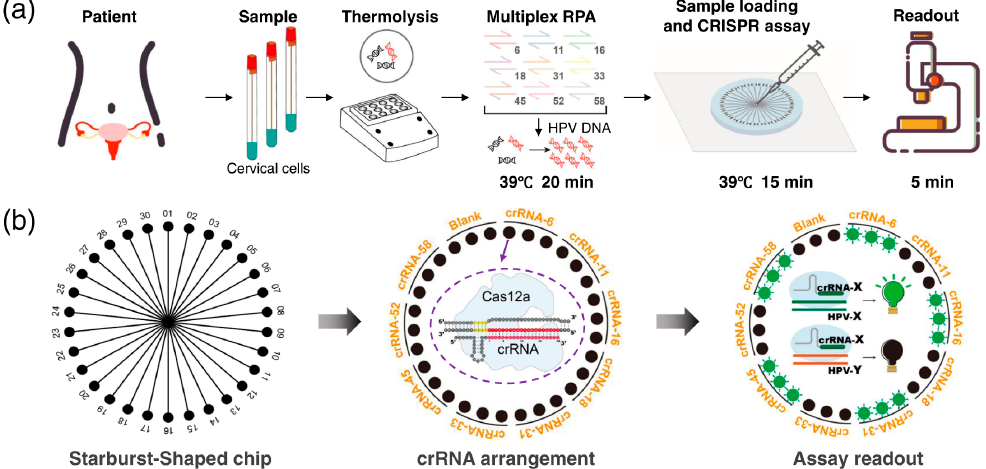
Figure 8. Schematic representation of the microfluidic device combined with CRISPR-Cas12a and multiplex recombinase polymerase amplification for detection of human papillomavirus (HPC). ( a ) Brief overview of the steps involved in the process. ( b ) On-chip testing principles. Reprinted with permission from [116]. Copyright (2022) Springer Nature.